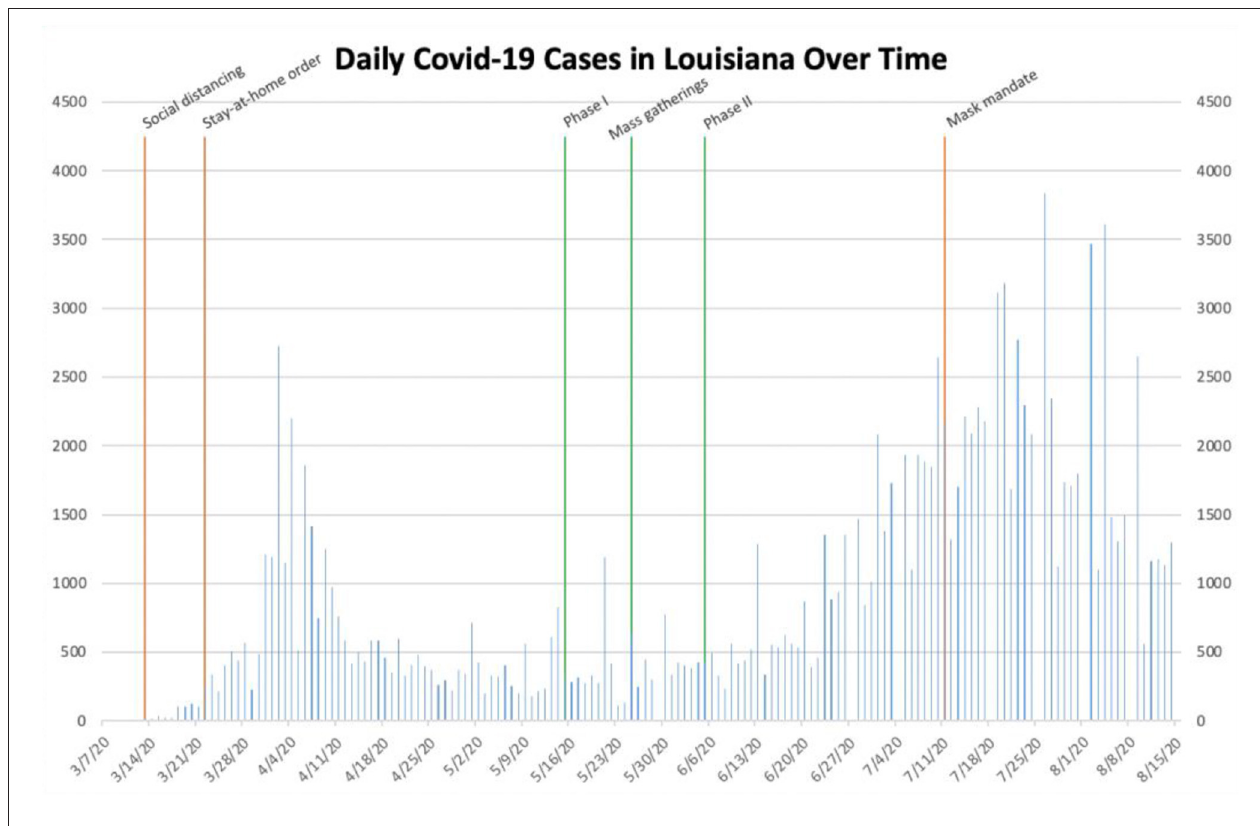
FIGURE 4 | Daily COVID-19 cases in